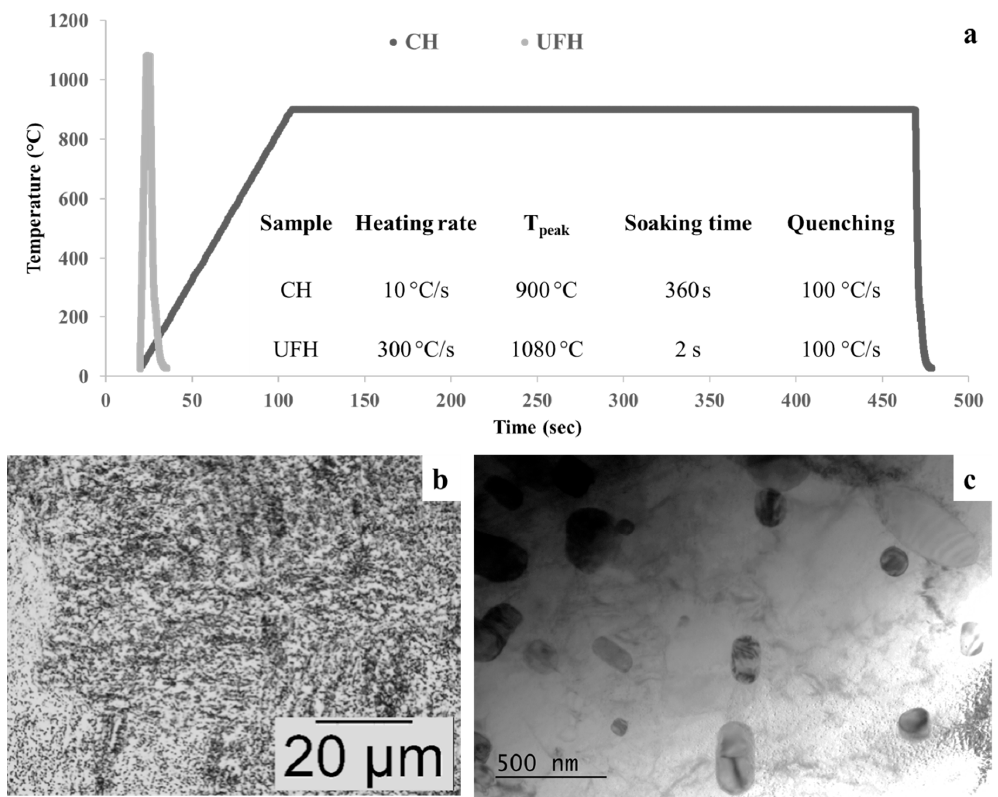
Figure 1. ( a ) The parameters of the two heat treatments that were studied, ( b ) the initial microstructure of both samples, as seen in the OM, consisted of ferrite (white) and spheroidized cementite (dark grey) ( c ) a bright field TEM image of the spheroidized cementite in the initial